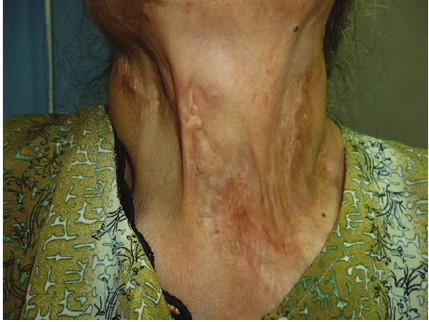
Figure 3: Nonpitting edema of the right leg and foot.